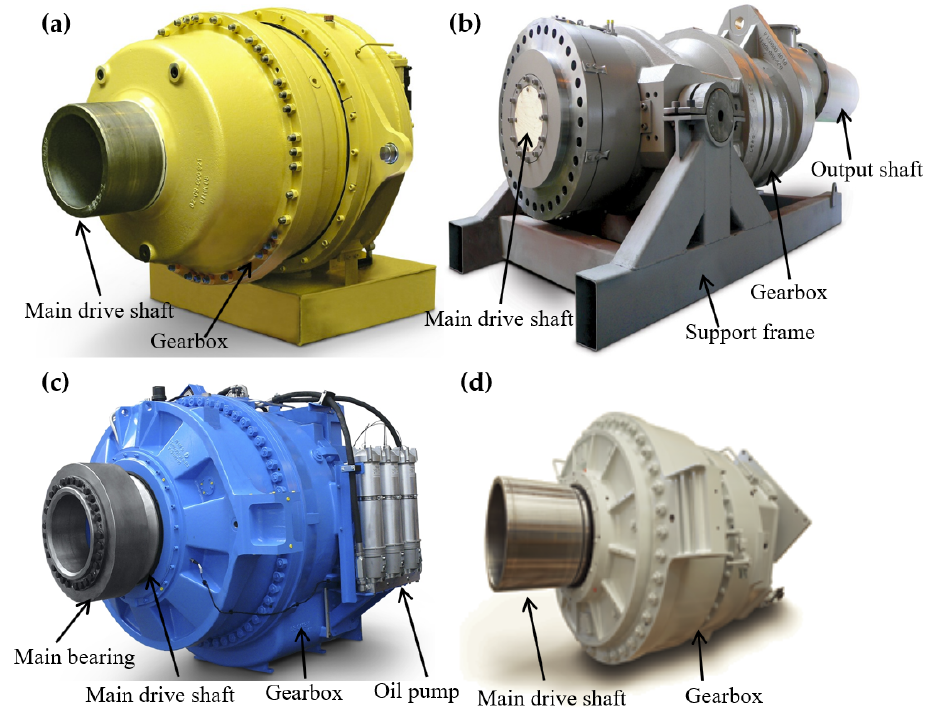
Figure 4. Some commercially developed planetary gearboxes of TCECs: ( a ) 500 kW planetary gearbox of a TGL turbine; ( b ) 650 kW planetary gearbox with a generator from a MCT’s SeaGen tidal current turbine; ( c ) 1.5 MW planetary gearbox from an Andritz Hydro’s MeyGen turbine; ( d ) 1.13 MW planetary gearbox from an Orbital Marine Power’s FloTEC SR2-2000 tidal current